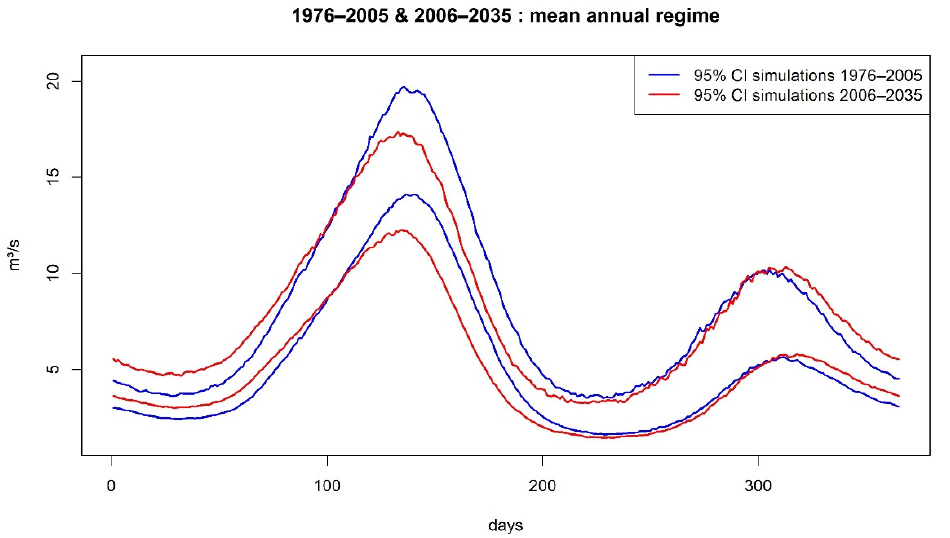
Figure 6. Mean annual regime: range of the 1000 simulations obtained with the whole framework (GCM+CDFt+HMM+MORDOR) (95% confidence interval): over period 1976–2005 (blue curves) and period 2006–2035 (red curves).